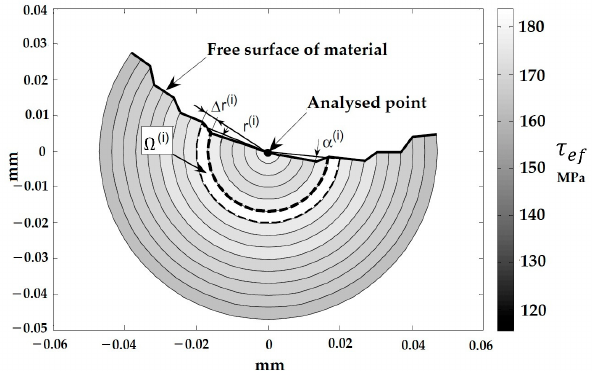
Figure 6. Example of effective shear stress distribution in SFI model [57].